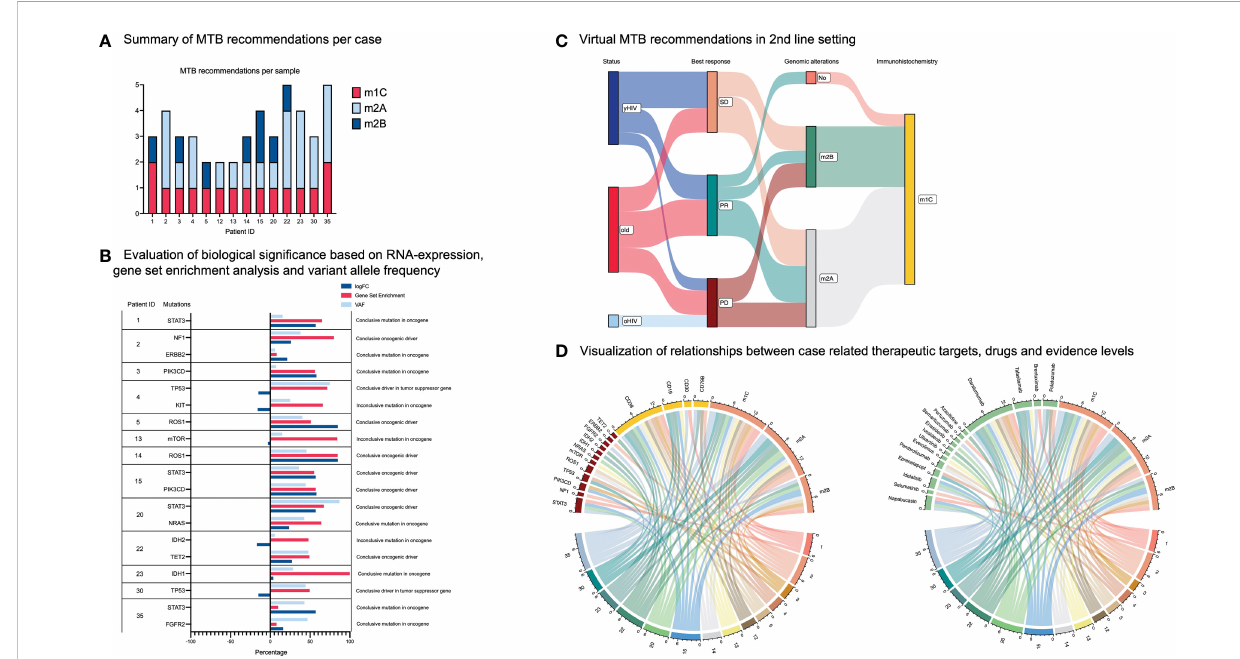
FIGURE 4 Therapeutic targets und treatment recommendations. (A) Case-related summary of MTB recommendations and associated molecular evidence levels. (B) Evaluation of RNA expression, gene set enrichment analysis and variant allele frequency (VAF) for each mutation serving as a therapeutic vulnerability. (C) Sankey plot allocating patients dependent on HIV status and age. The plot shows the best response of prPBL patients after standard chemotherapy. Moreover, the Sankey plot illustrates therapeutic vulnerabilities beyond standard chemotherapy based on genomic alterations and immunohistochemical targets. (D) Both chord plots demonstrate the relationships between cases and potential therapeutic targets, drugs and related evidence